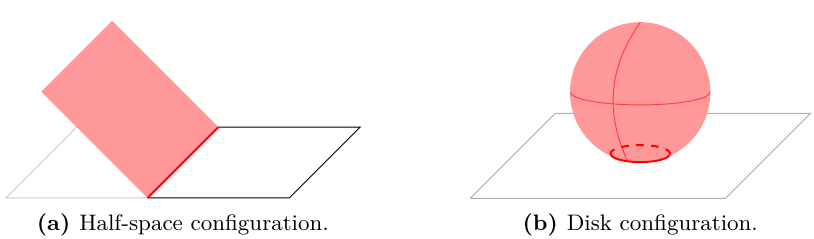
Figure 19. The bulk configuration obtained when selecting a leaf of (a) the planar foliation or (b) the disk foliation as an end-of-the-world KR brane (in red). For the half-space configuration, we excise the part of the bulk “behind” the brane. For the disk configuration, we excise the part of the bulk “outside” of the